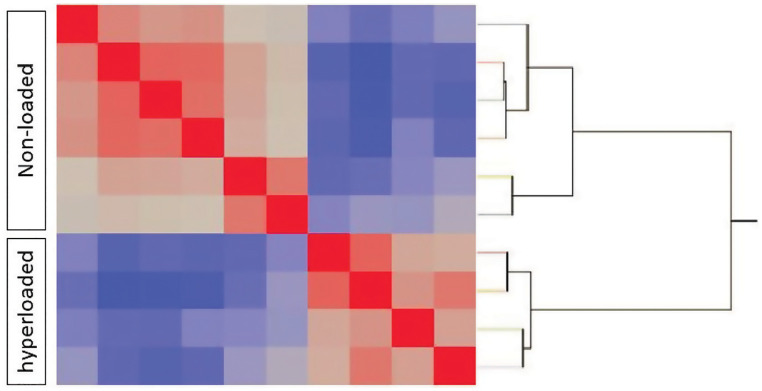
Heat map of up- and down-regulated transcripts mapped with a dendrogram (red = up-regulated [n = 348]; blue = down-regulated [n = 430]; grey = unchanged [n = 10590]).The changes in gene expression self-segregated to form distinct quadrants for Non-loaded and Hyperloaded groups.